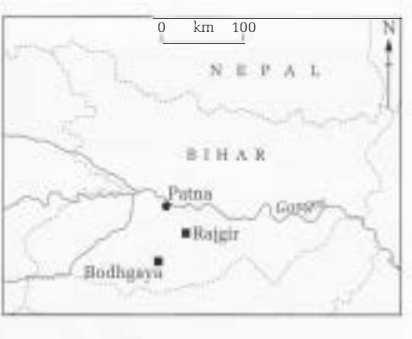
Figure 1 Bihar state, showing the loca­ tion of Rajgir and other places mentioned in the text.